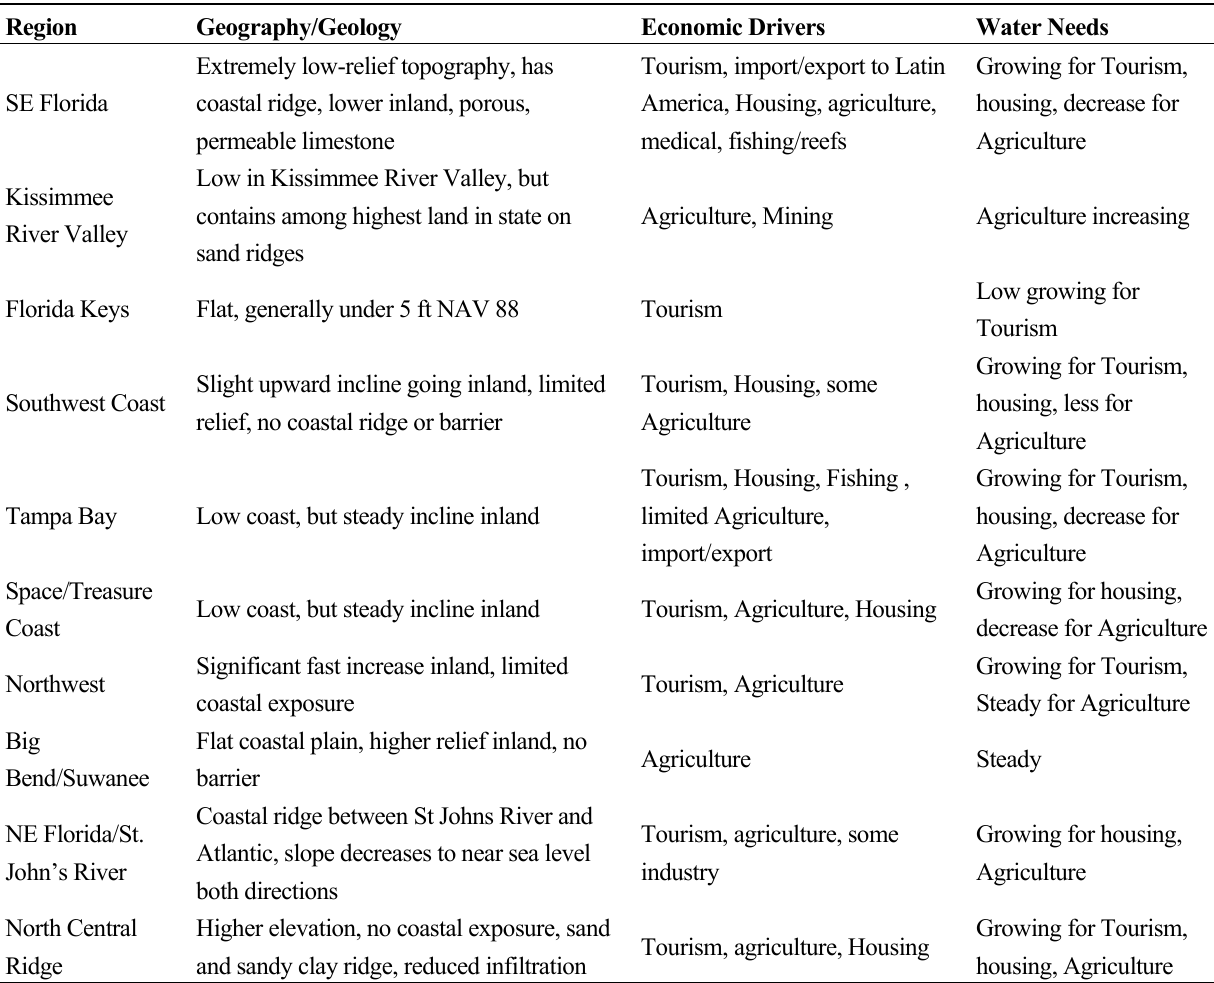
Table 1. Outline of the 10 areas of the state created for this